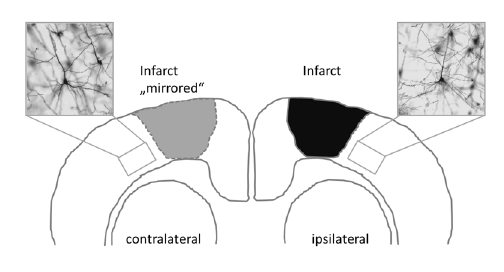
Fig 1. Topographic localization of the photothrombotic infarct. Note that infarct was mirrored on the contralateral side to analyze Golgi Cox-impregnated cortical layer V pyramidal neurons in the ipsilateral peri- infarct cortex and in the corresponding contralateral cortex (Insets: representative Golgi Cox-impregnated cells).